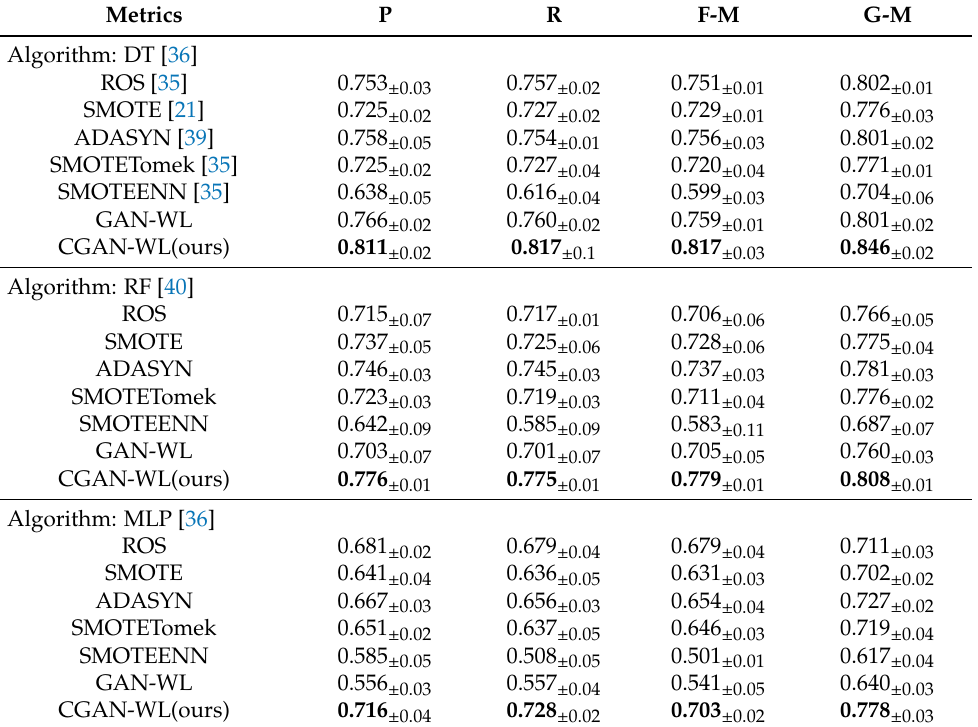
Table 4. Averages of metrics by different methods using different classifiers on the Refractive errors DataSet [41]. The bold characters are highlighted as the best